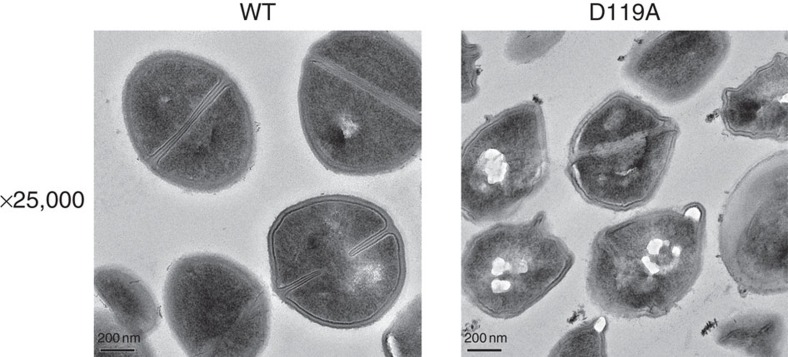
Transmission electron microscopy test showed mutation of the potential signal-transduction residue (D119A) resulted in defective cell morphology.Cells were grown to OD600 of ∼0.6 before harvesting for analysis. Scale bars, 200 nm.